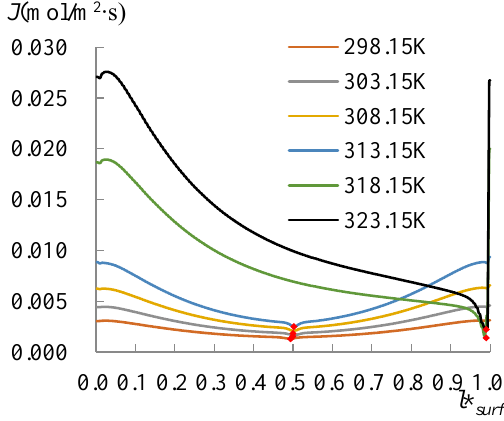
Figure 10. Evaporation flux at the LA interface. Evaporation flux is proportional to the local surface temperature; hence, a similar trend of its distribution is shown as the temperature distribution.